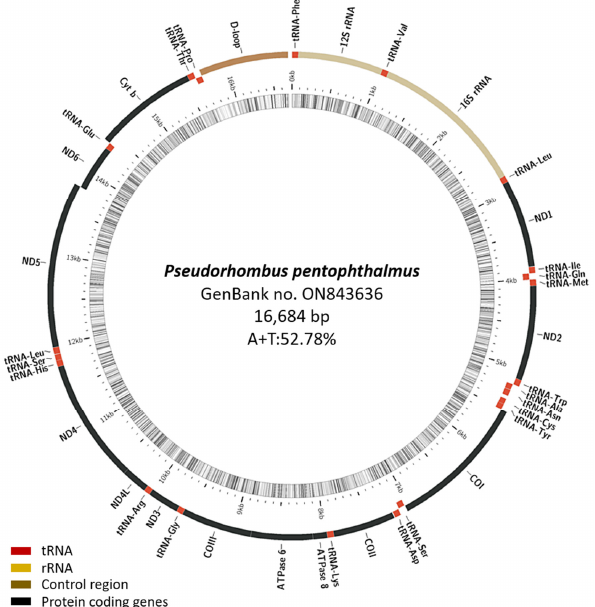
Figure 1. The complete mitochondrial genome of fivespot flounder, Pseudorhombus pentophthalmus , GenBank accession number ON843636, drawn by the MitoFish/MitoAnnotator online server (http://mitofish.aori.u-tokyo.ac.jp/annotation/input/, accessed on 3 February 2023). Genes outside the circle are transcribed in a clockwise direction, and those inside are transcribed in a counterclockwise direction.